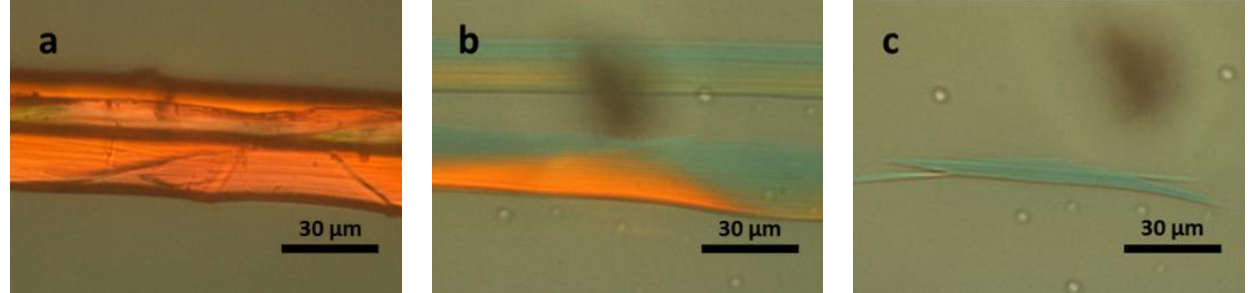
Figure 6. POM image of silk fibres dissolving in [Bmim]OAc at 120 °C: ( a ) native silk fibre; after ( b ) 120 s; and ( c ) 240